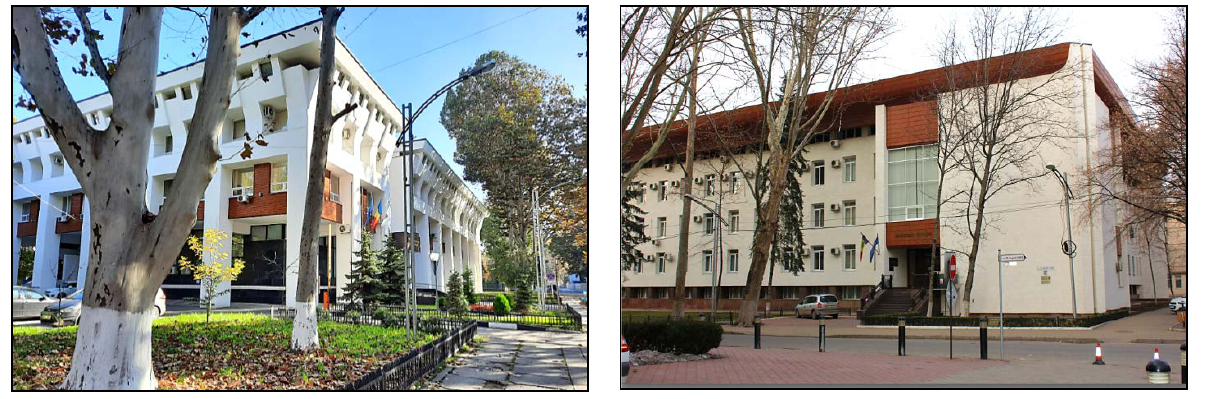
Figure 9. The Institute of History of CPM, 1978.